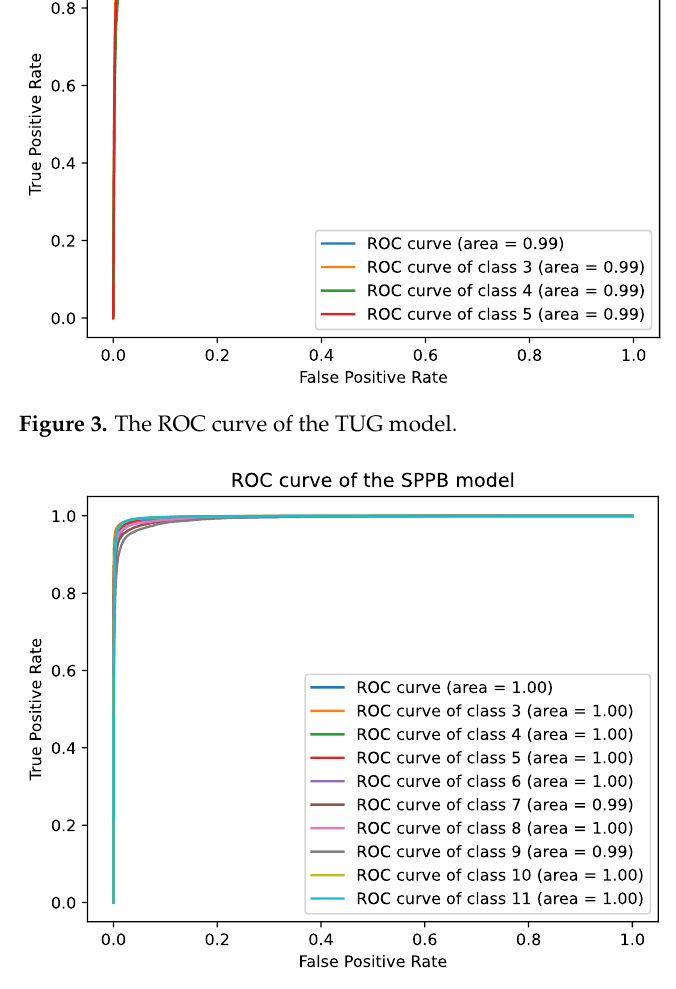
of the TUG model. Figure 8. The ROC curve of the SPPB model. Figure 4. The ROC curve of the SPPB Figure 7. The ROC curve